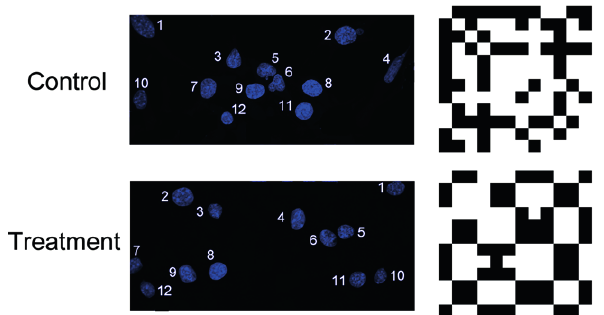
Figure 11. Two indistinct images of control and treated cell popu- lations yielding drastically diff erent cell distance checkerboard pat-